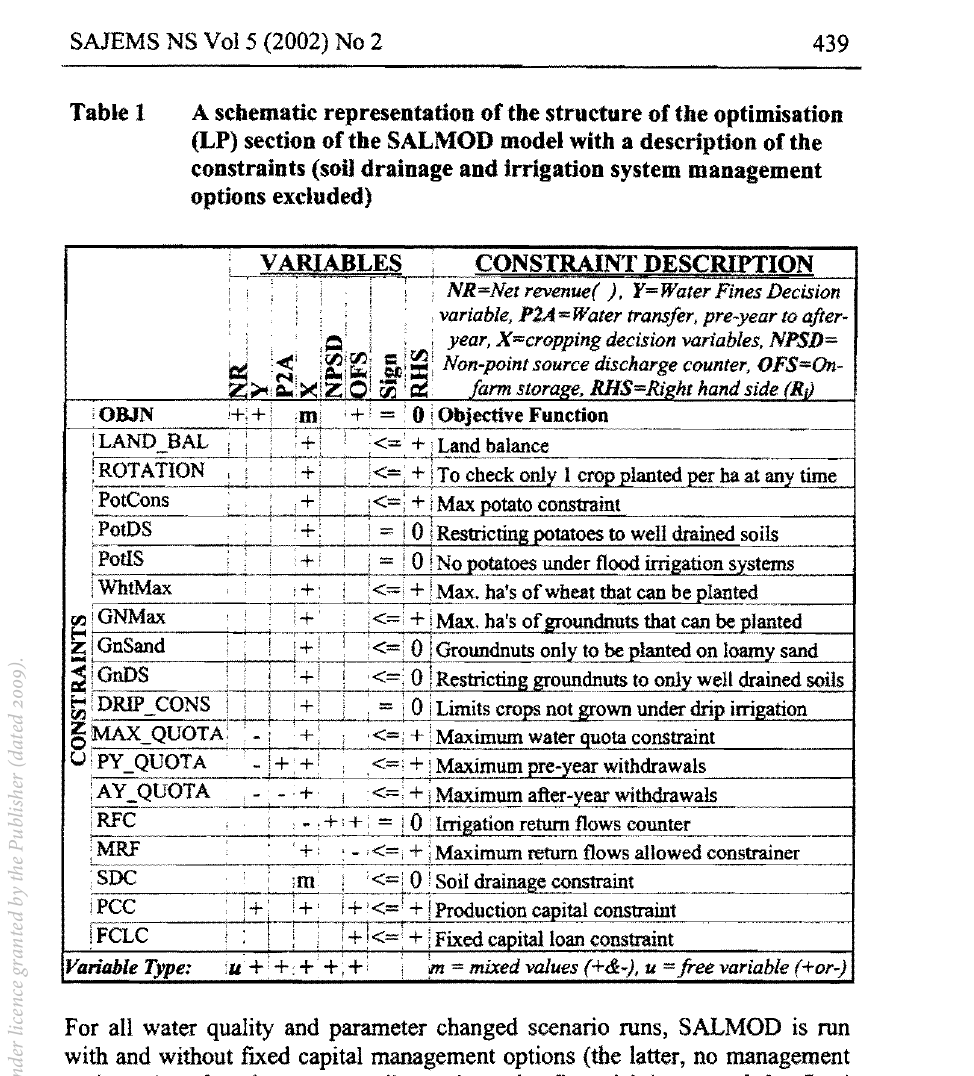
A schematic representation of the structure of the optimisation (LP) section of the SALMOD model with a description of the constraints (soil drainage and irrigation system management